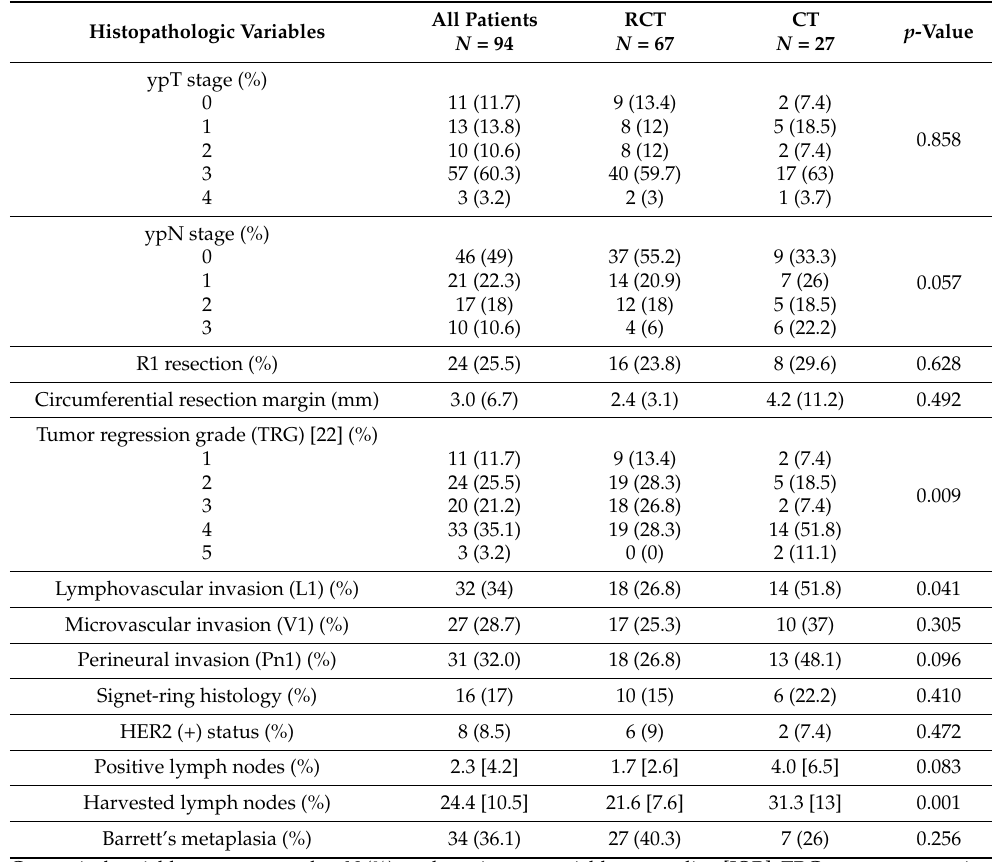
Table 3. Histopathologic characteristics of the surgical